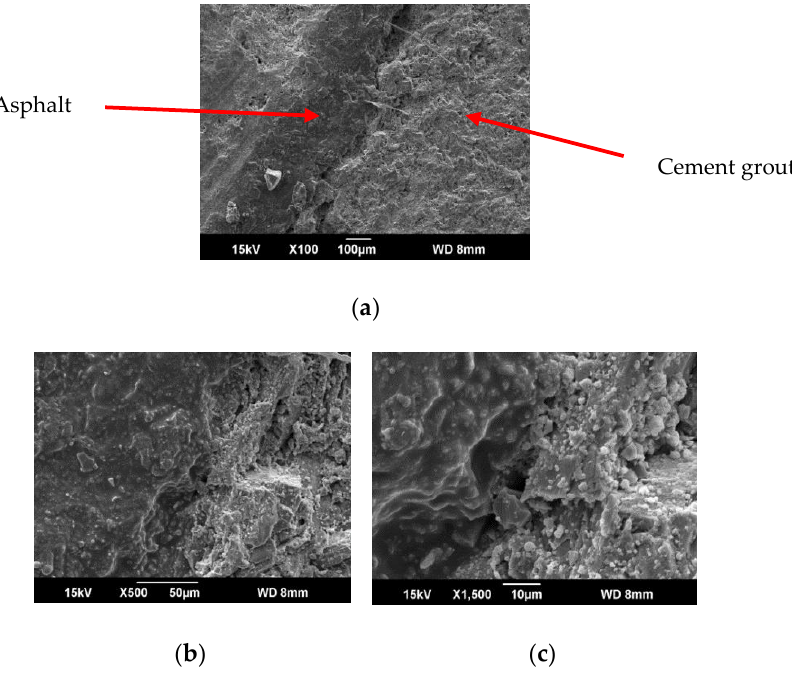
Figure 4. Microstructure of cement-asphalt interface modified by carboxyl styrene-butadiene latex with different sizes: ( a )100 μ m;( b ) 50 μ m; ( c ) 10 μ m.